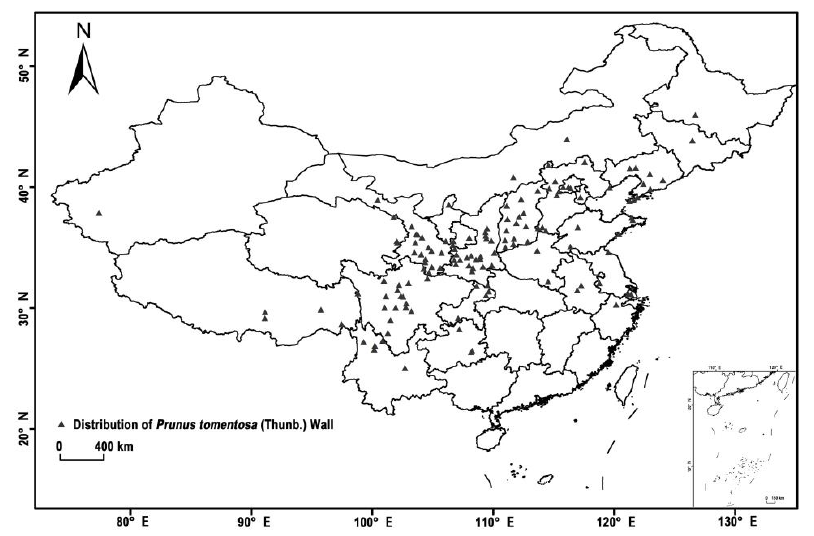
Figure 1. Distribution record of Prunus tomentosa (Thunb.) Wall in China. The gray dots in the figure represent the existing distribution of P. tomentosa